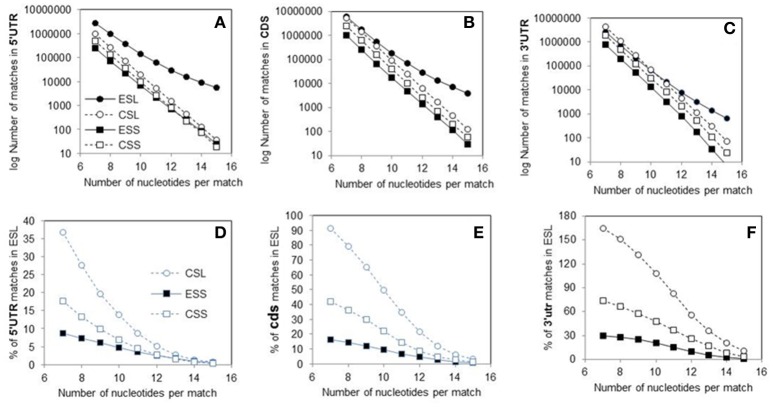
Counts of canonical contiguous 7–15 nucleotide matches of human rRNA segments with human mRNA sectors. (A) Matches in 5′utr. (B) Matches in cds. (C) Matches in 3′utr. Percentages of the numbers of matches relative to ESL are shown in graph (D) for 5′utr, in graph (E) for cds, and in graph (F) for 3′utr. In Wilcoxon signed-rank (paired) test at p < 0.01 the numbers of matches in ESL were higher than those in ESS for all three sectors, and also higher for 5′utr and cds. The percentage of matches relative to ESL tested as lower in 5′utr for all other rRNA segments, and in cds and 3′utr for ESS. The percentage of CSL matches relative to ESL in 3′utr however tested as higher. Slopes of the linear regressions on number of nucleotides in segment vs. log10 of match count for 5′utr, cds and 3′utr were: in ESL, −0.3402, −0.4087, and −0.4586; in CSL, −0.5551, −0.5851, and −0.5936; in ESS, −0.5204, −0.5631, and −0.6069; in CSS, −0.5356, −0.5748, and −0.6669. In linear regressions the ESL slopes were much lower than in other segment groups, with no overlaps at double SD (see Table 1). The r2-values were above 0.99 in all regressions.